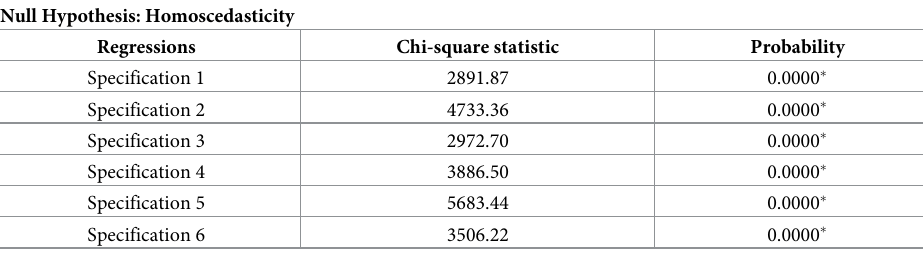
Table 4. Wald test for heteroscedasticity (direct